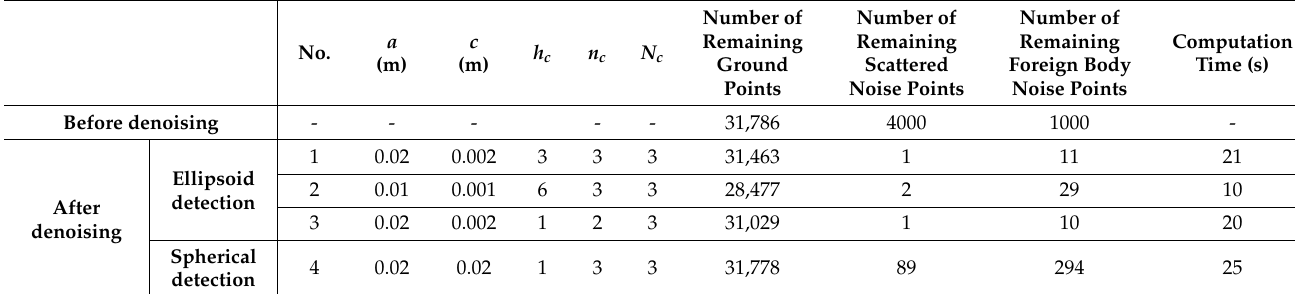
Table 2. The denoising results of the simulated point cloud by different denoising parameters.